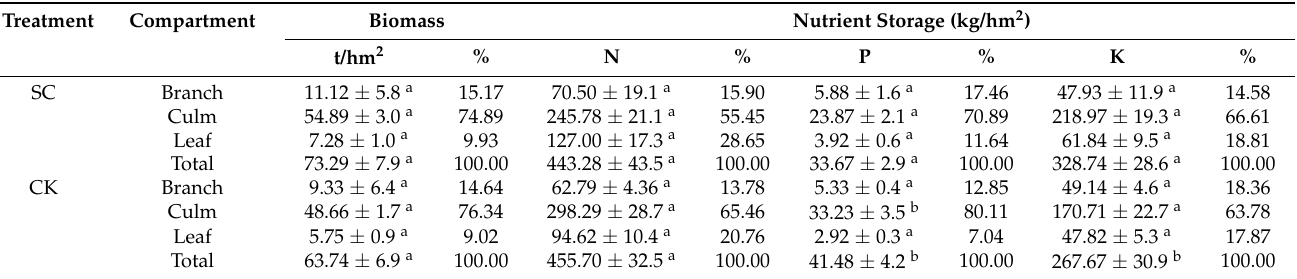
Table 3. Biomass (t/hm 2 ) and nutrient storage (kg/hm 2 ) of tree compartments of Moso bamboo at strip clearcut (SC), and traditional management (CK) plots.